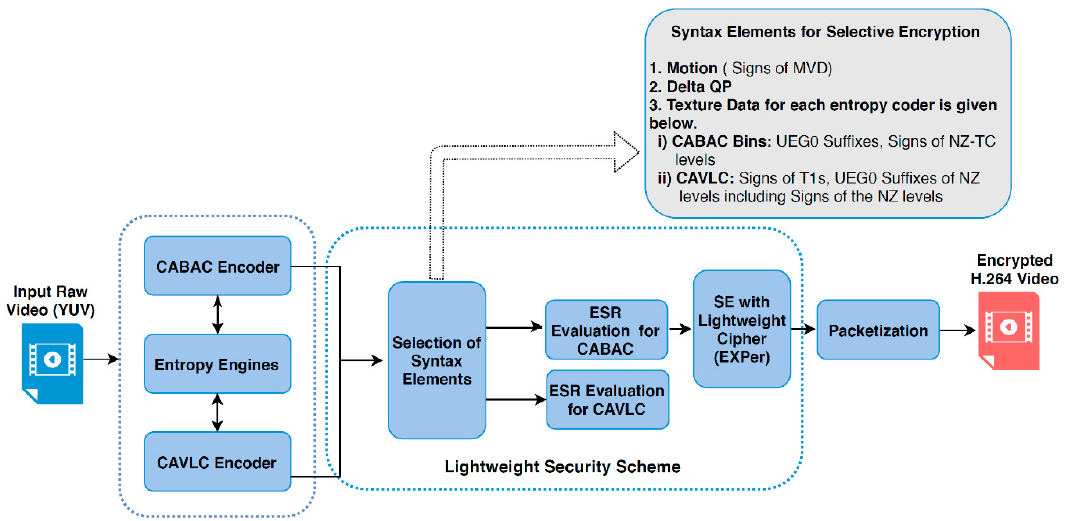
Figure 2. Block diagram of the proposed lightweight security scheme.